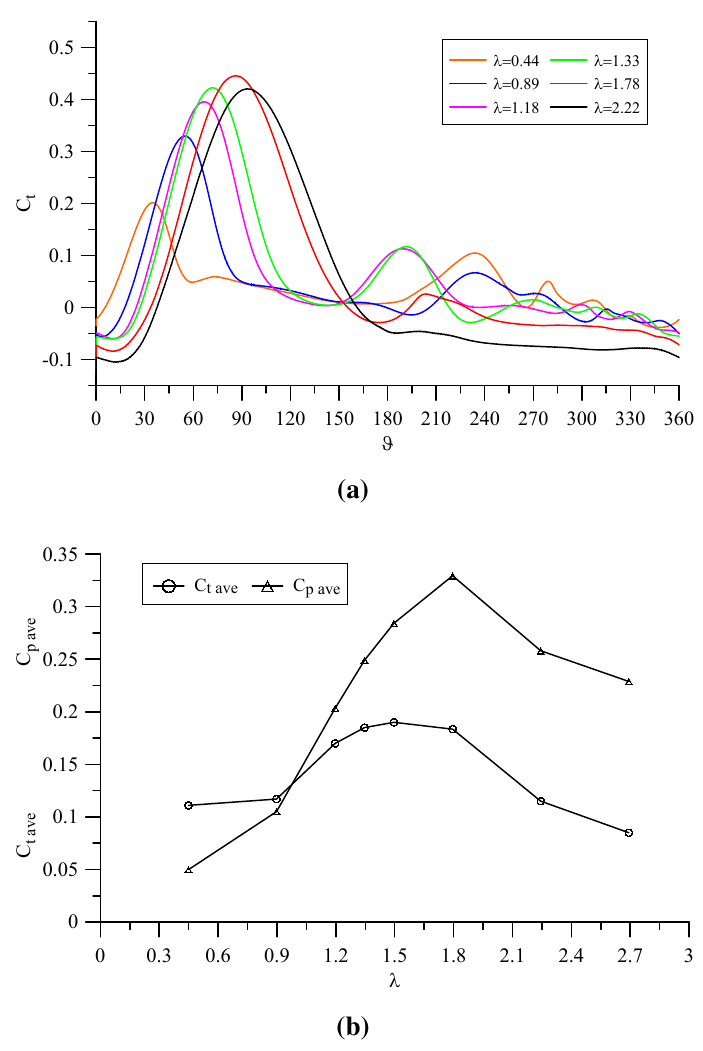
Figure 6. Torque and power coefficients as a function of azimuthal position and λ . ( a ) Instantaneous torque coefficient ( C ) for a single blade with respect to the azimuthal t position ( θ ) at various tip speed ratios ( λ ); ( b ) rotor average torque coefficient ( C average power coefficient ( C ) with respect to tip speed ratio ( λ p